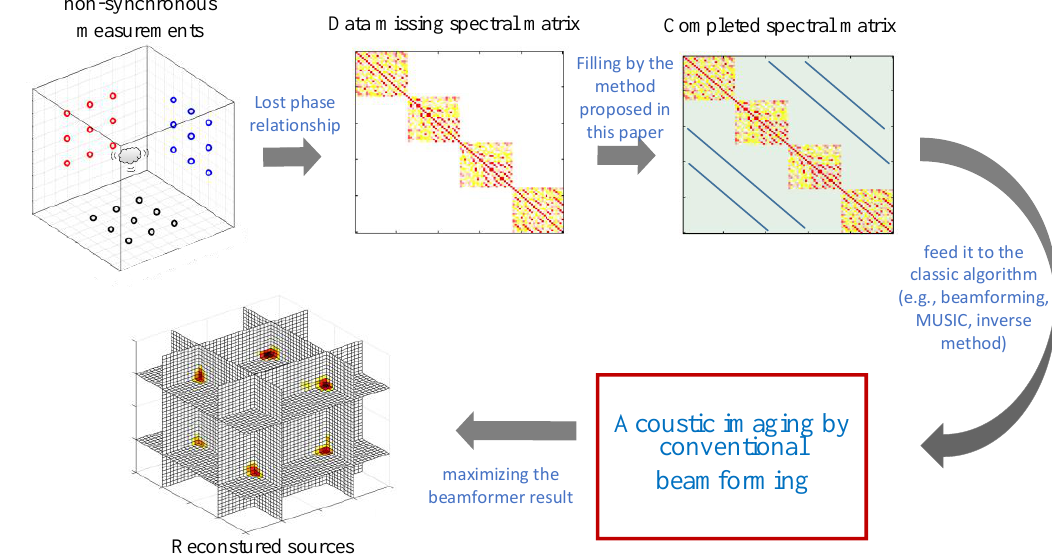
non-synchronous measurements. Then the data-missing spectral matrix is filled with data to obtain the complete spectral matrix. Finally, acoustic imaging is achieved by conventional